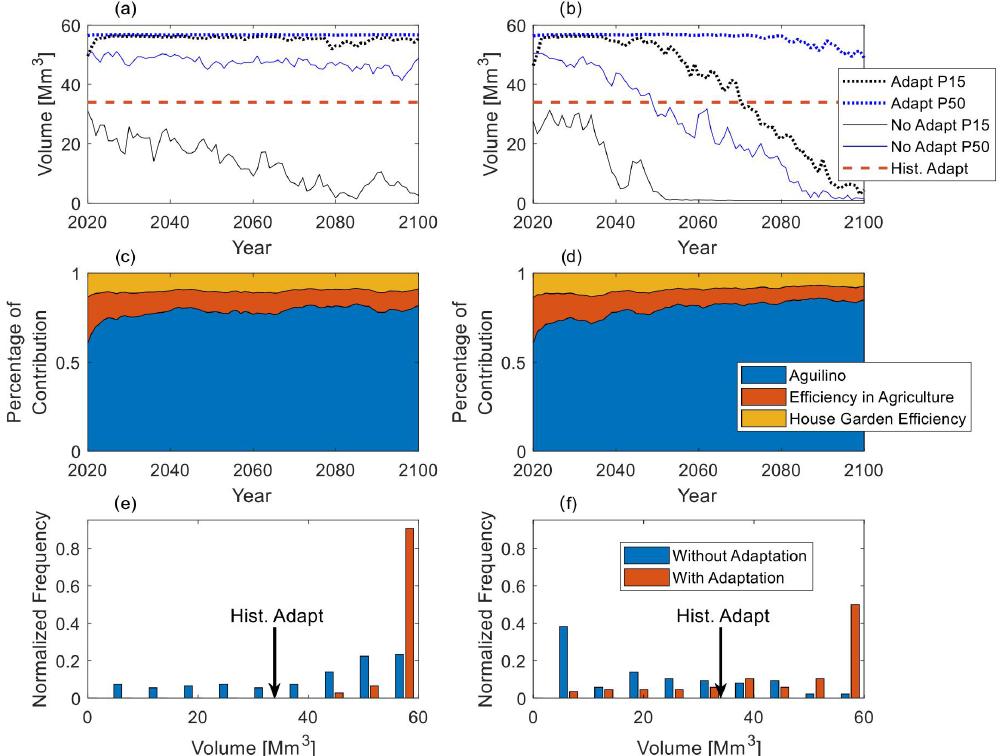
Figure 4. WEAP model water balance results under the combination of strategies: (a) annual lake water volume simulated under the RCP4.5 scenario; (b) same as (a) but under RCP8.5 scenario; (c) projected percentage of contribution of each strategy under the RCP4.5 scenario; (d) same as (c) but under RCP8.5 scenario; (e) normalized water volume frequency using different GCM simulations for the period 2071– 2100 under the RCP4.5 scenario; (f) same as (e) but under RCP8.5